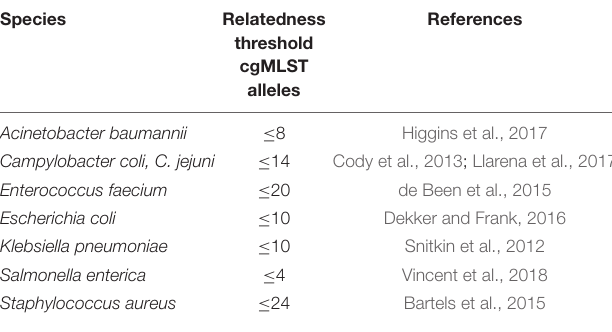
TABLE 1 | Relatedness criteria used for the cgMLST schemes for clinically relevant